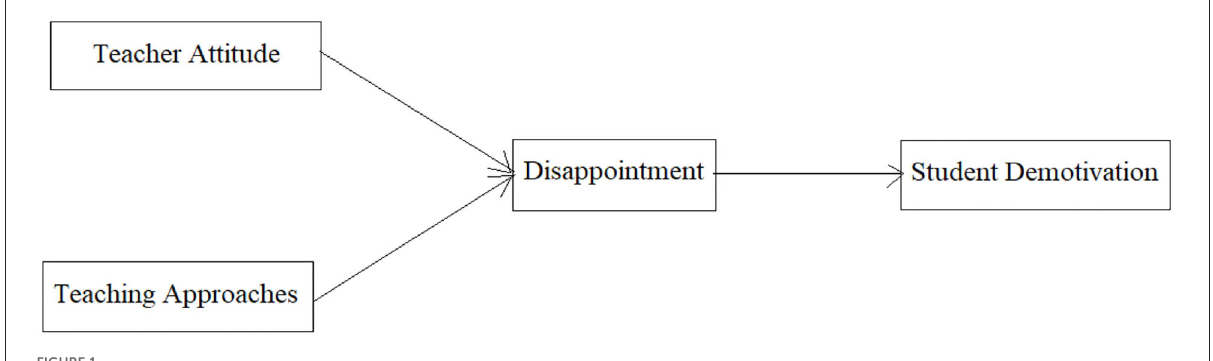
FIGURE1 The theoretical